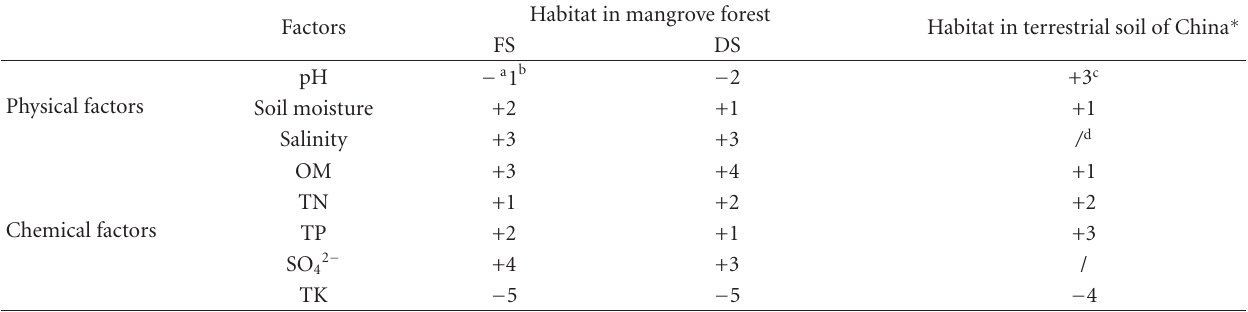
Table 8: Relationship comparison of soil ciliate abundance on physical/chemical factors between mangrove soil habitats and terrestrial soil